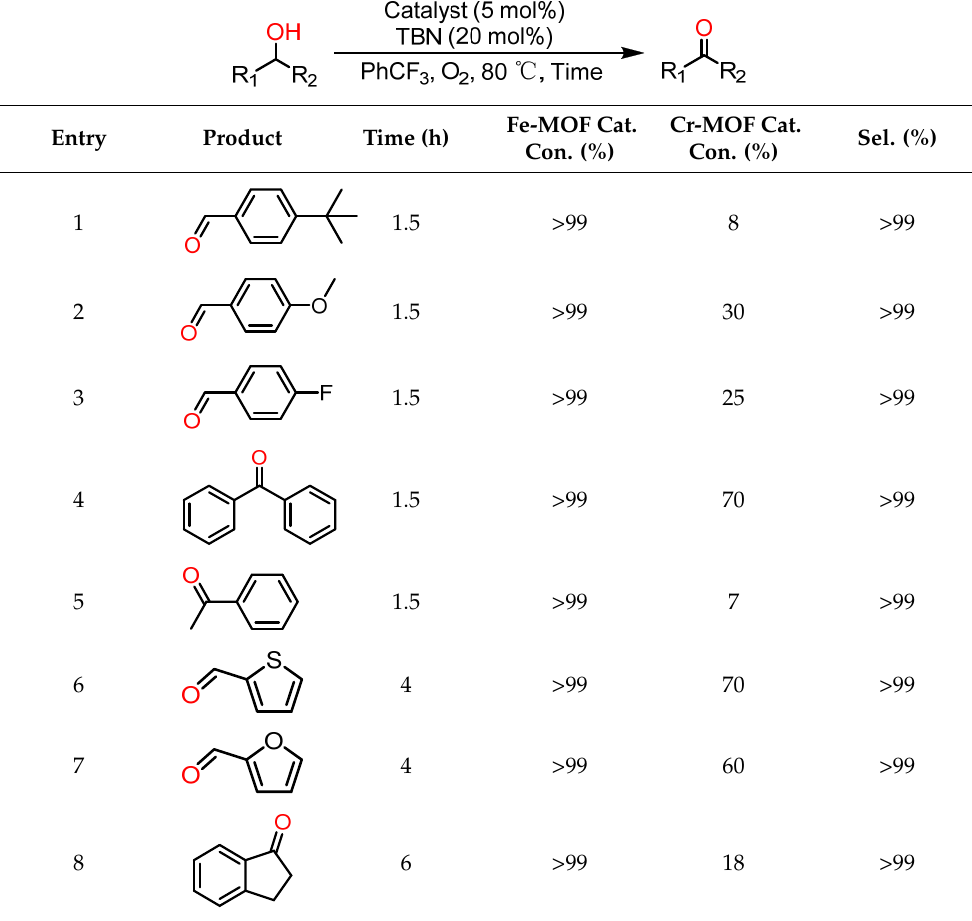
Table 2. MIL-101(Fe) or MIL-101(Cr) catalyzed aerobic oxidation of various alcohols.